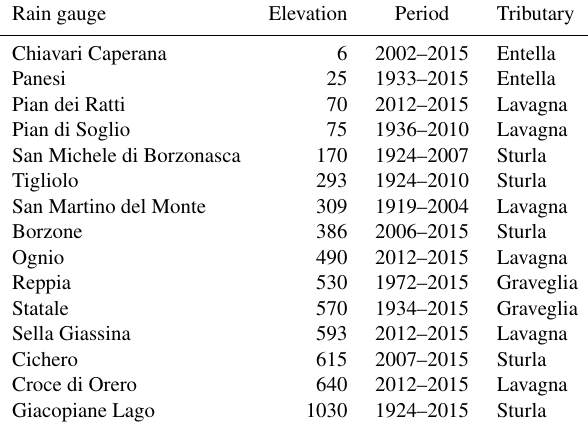
Table 2. Rain gauges in the Entella River catchment used to analyze the rainfall conditions that have resulted in landslides in the catch- ment, in the 15-year period 2002–2016 (Fig. 1). Rainfall records are locally incomplete, and measurements are not available for all rain gauges in the period